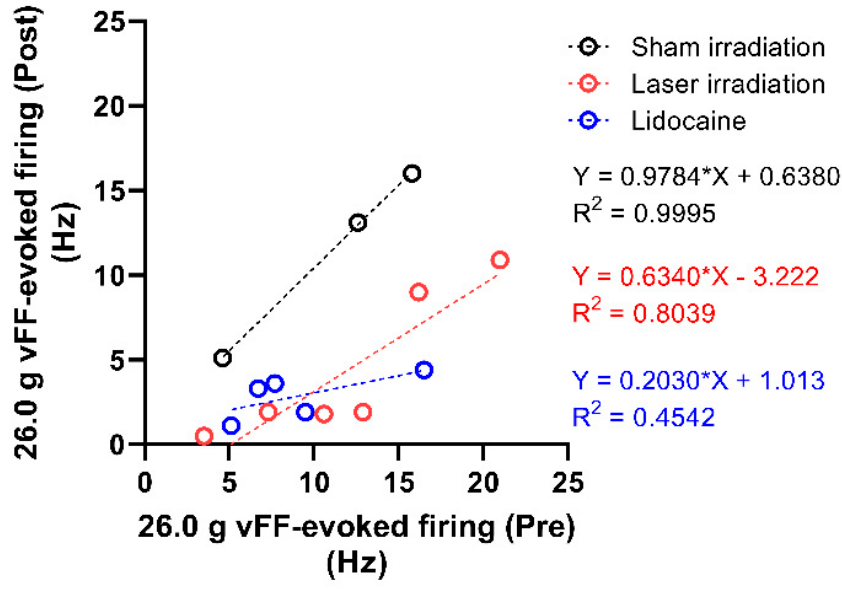
Figure 5. Correlation between the 26.0 g vFF-evoked firing before and after intervention for laser irradiation, sham irradiation, and lidocaine administration, respectively. For laser and sham irradia- tion, the values on the vertical axis depict the values recorded 15 min after irradiation. For lidocaine, the vertical axis depicts the values recorded 5 min after the administration. Each dot in the figure is shown as a response of an individual neuron; vFF, von Frey filaments.